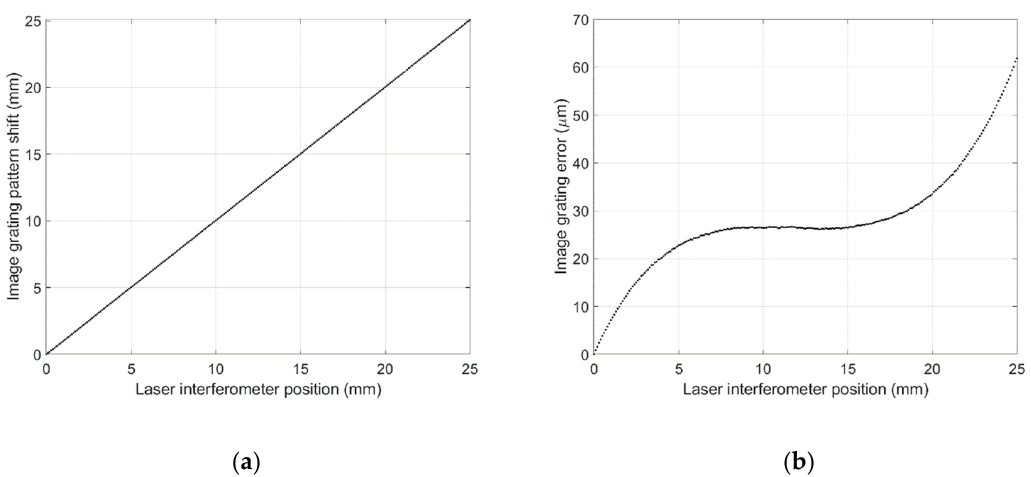
Figure 11. ( a ) Pattern shift (mm) in the image grating system; ( b ) Measurement error of the image grating system.